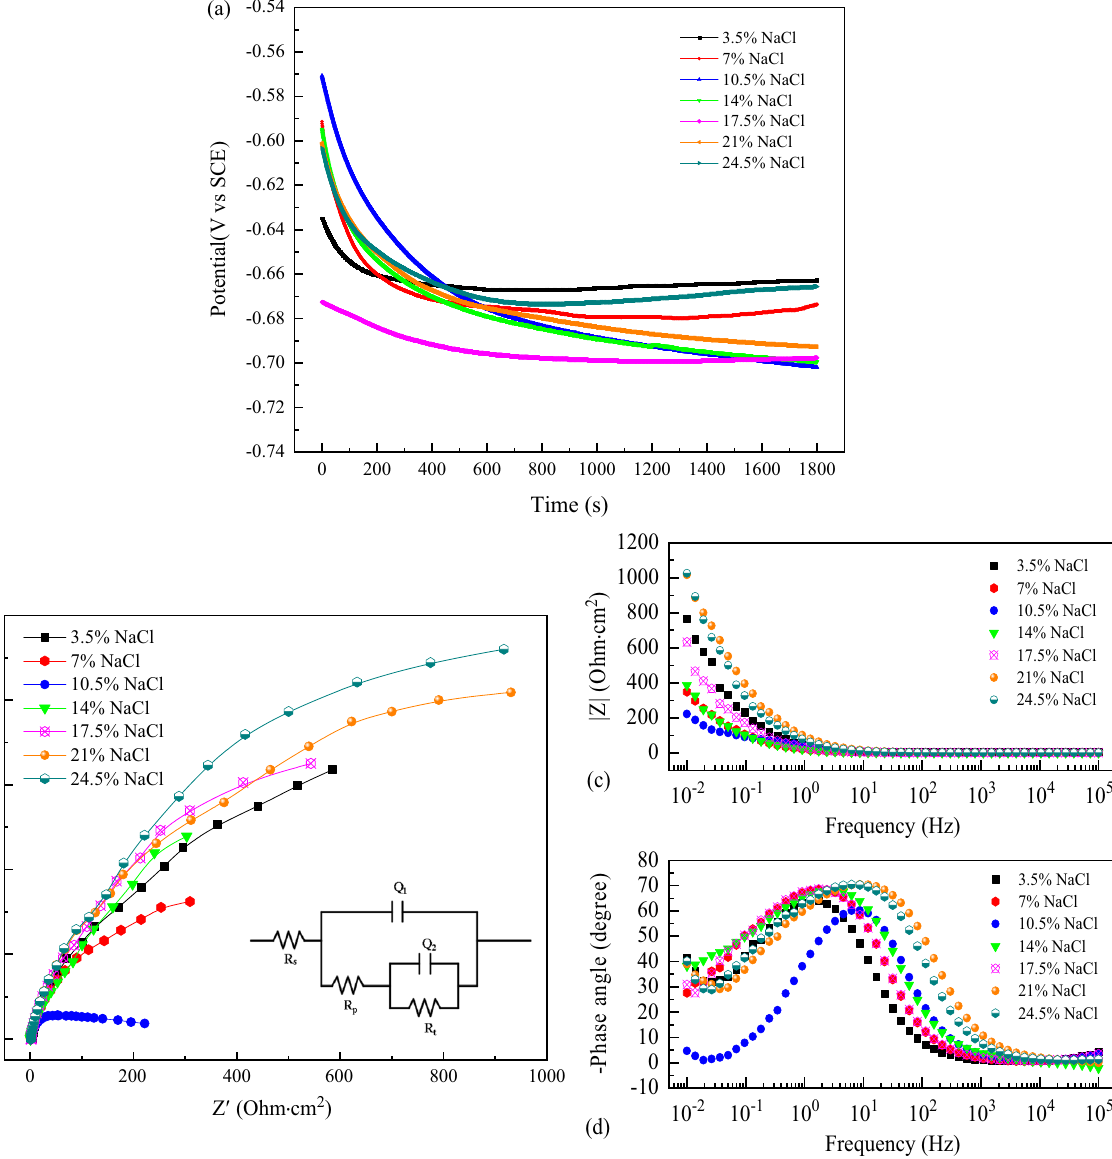
Figure 2: Electrochemical impedance and OCP of the samples in NaCl solutions with di ff erent concentrations: ( a ) OCP; ( b ) Nyquist plot; ( c ) frequency - impedance modulus curve; ( d ) frequency - phase angle